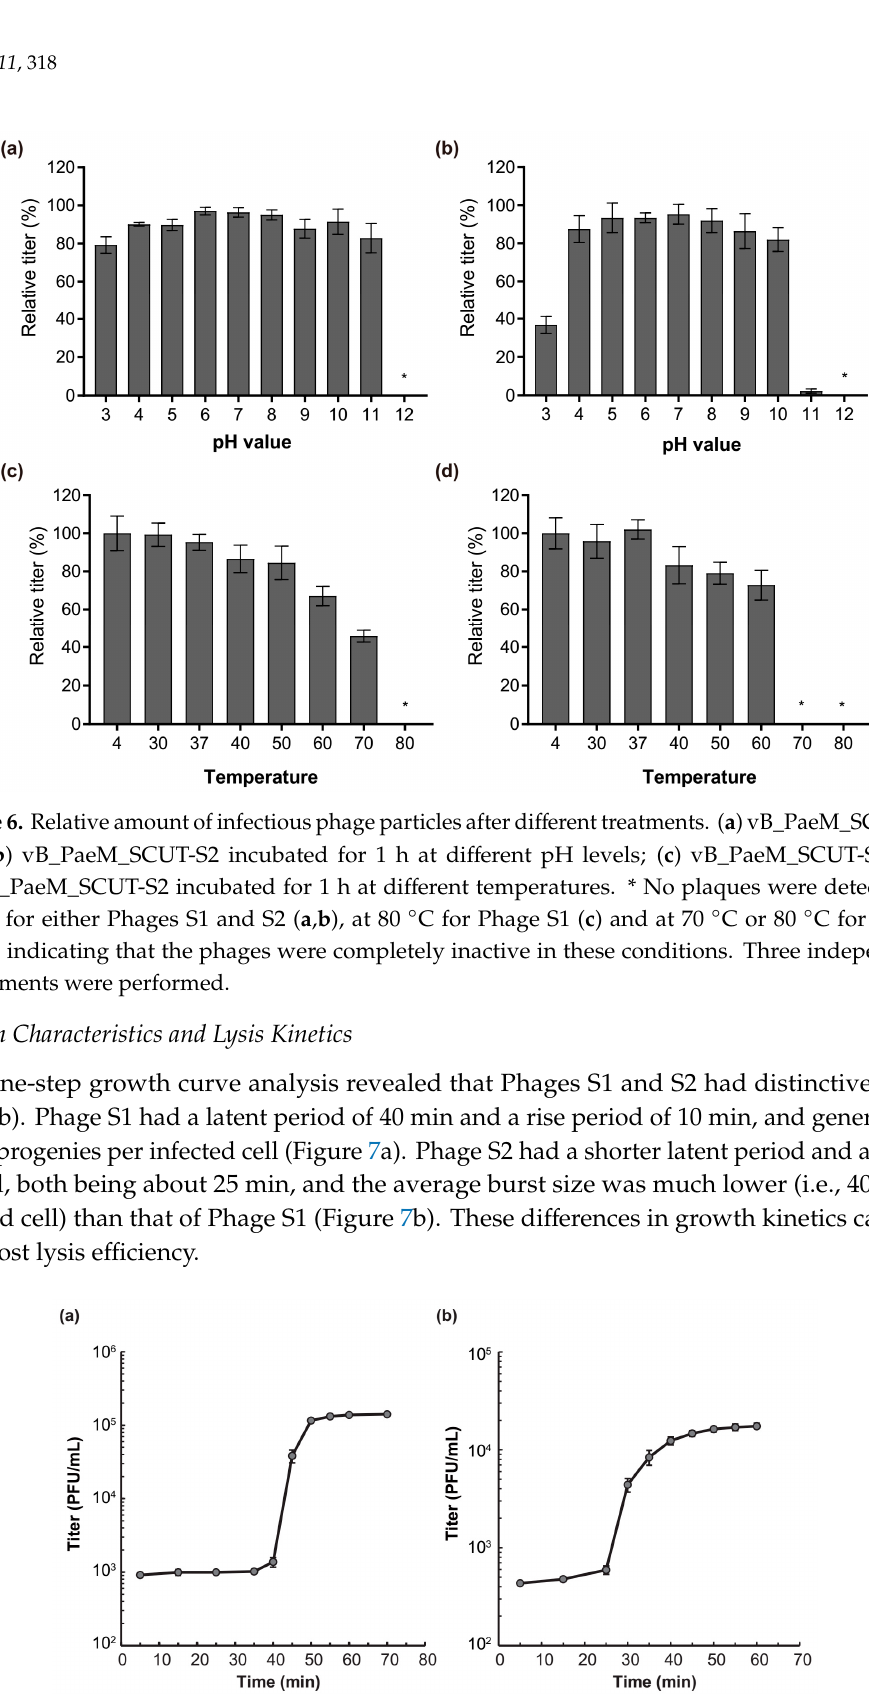
Figure 7. One step growth curve of ( a ) vB_PaeM_SCUT-S1 and ( b ) vB_PaeM_SCUT-S1. Data are presented as the mean ( ± standard deviations) titers measured at the indicated infection time obtained from three independent experiments.